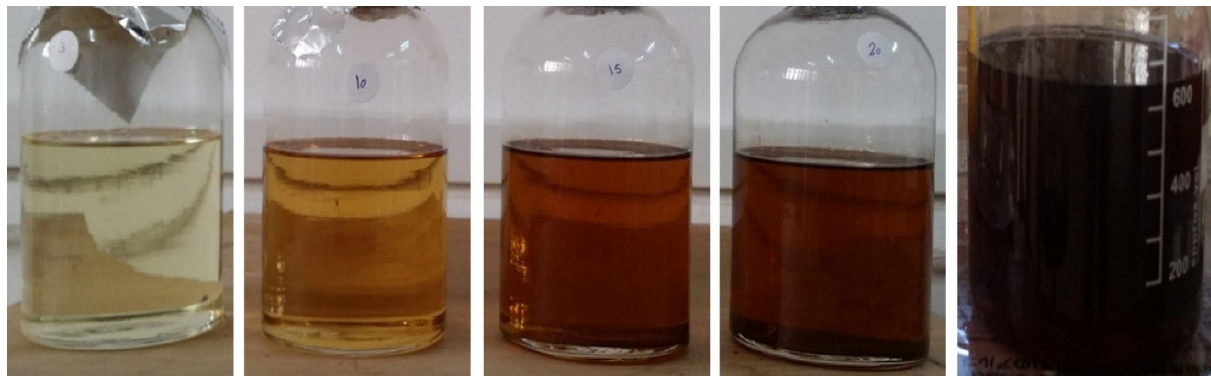
Figure 8. Different aged samples (L-R 3-Day, 10-Day, 15-Day, 20-Day, and 30-Day) [7] .